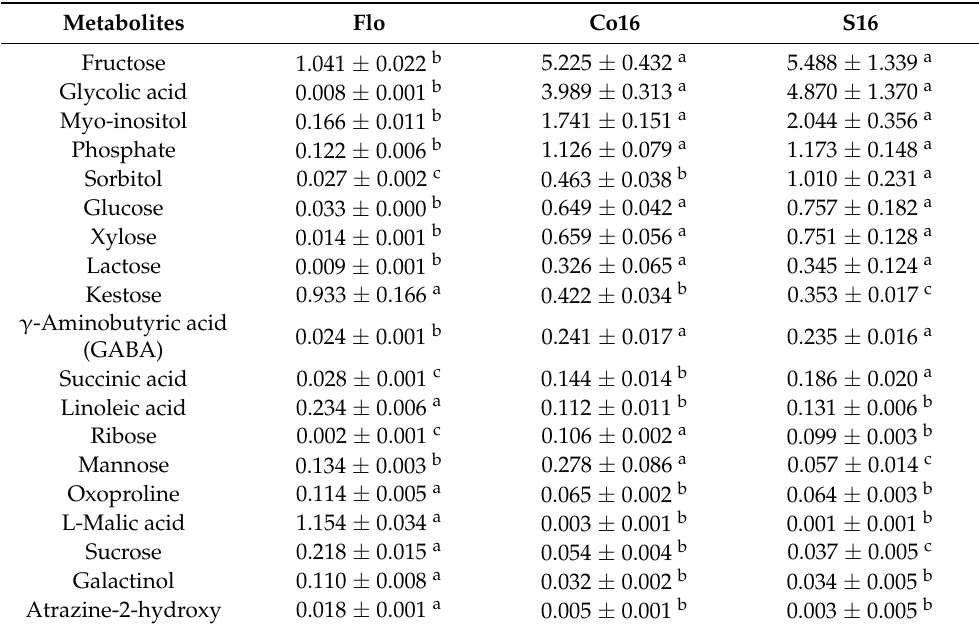
Table 1. Key metabolites (g/100 g) of fresh dough, sourdough, and sourdough artificially contami- nated with S. aureus